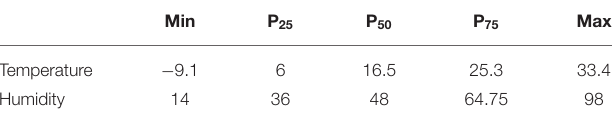
Frontiers in Medicine |